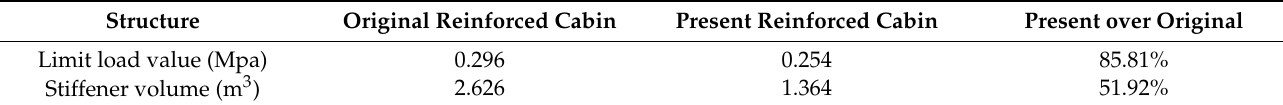
Table 3. Comparison of the effect of the rationalized design of the ribs.